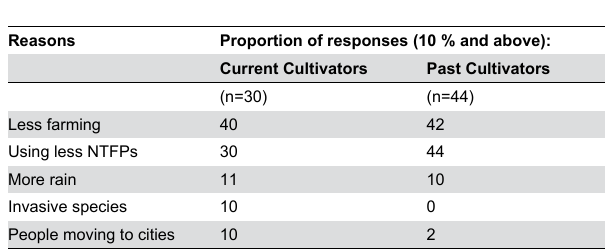
Table 6. Reasons provided by current and past cultivators regarding why forests are increasing (N=74).